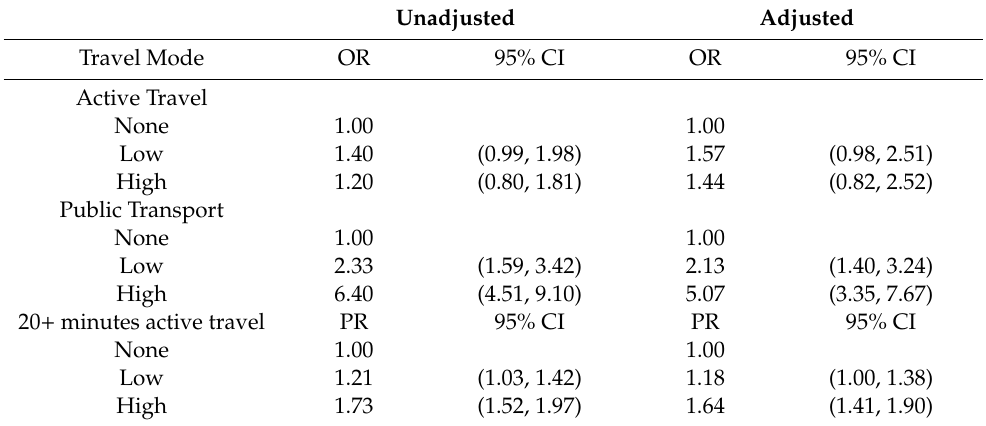
Table 3. Associations between public transport accessibility at school on the likelihood of taking active or public transport to school compared to cars, and the likelihood of achieving 20 min of active travel on the journey to school ( n =